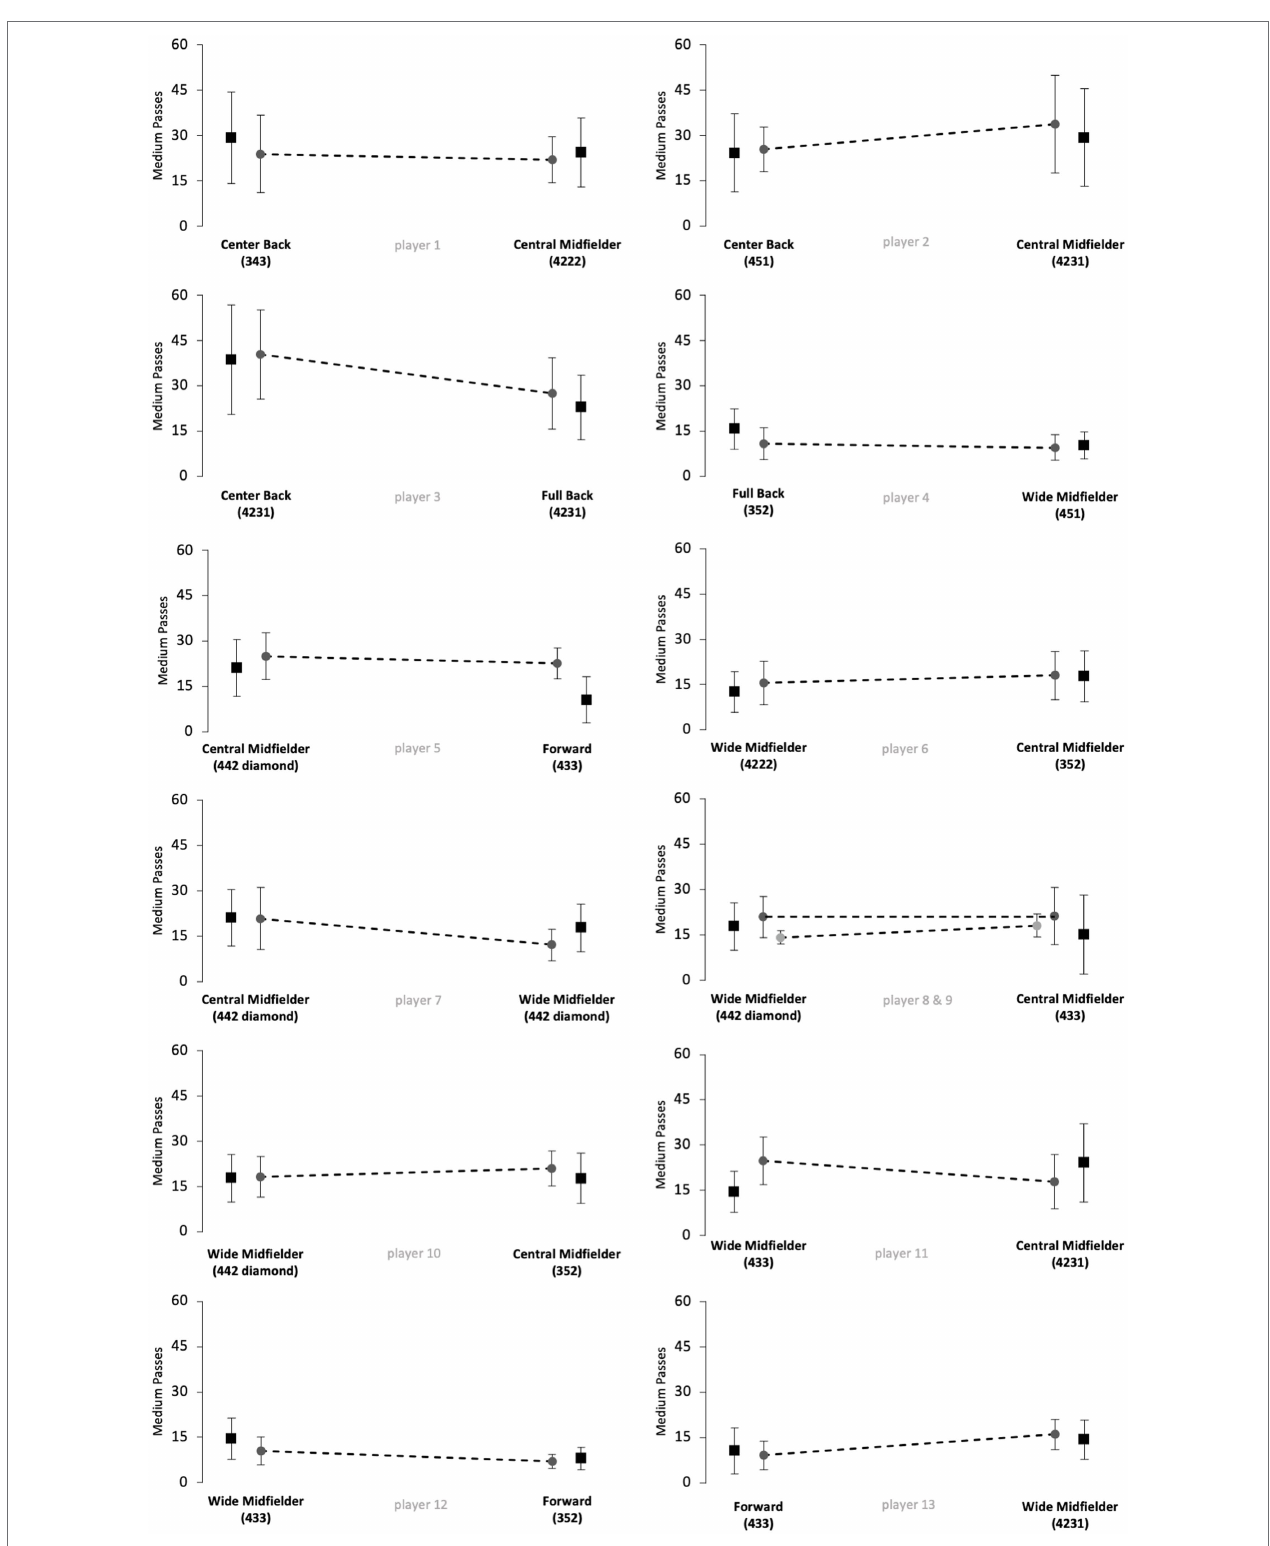
FIGURE 2 | Number of medium passes of players from the study sample (grey circles) in relation to normative positional data (black squares). Data are presented as means ± SD for the respective games played on the respective positional role. Solid lines indicate significant differences in performance between the two positions for the respective